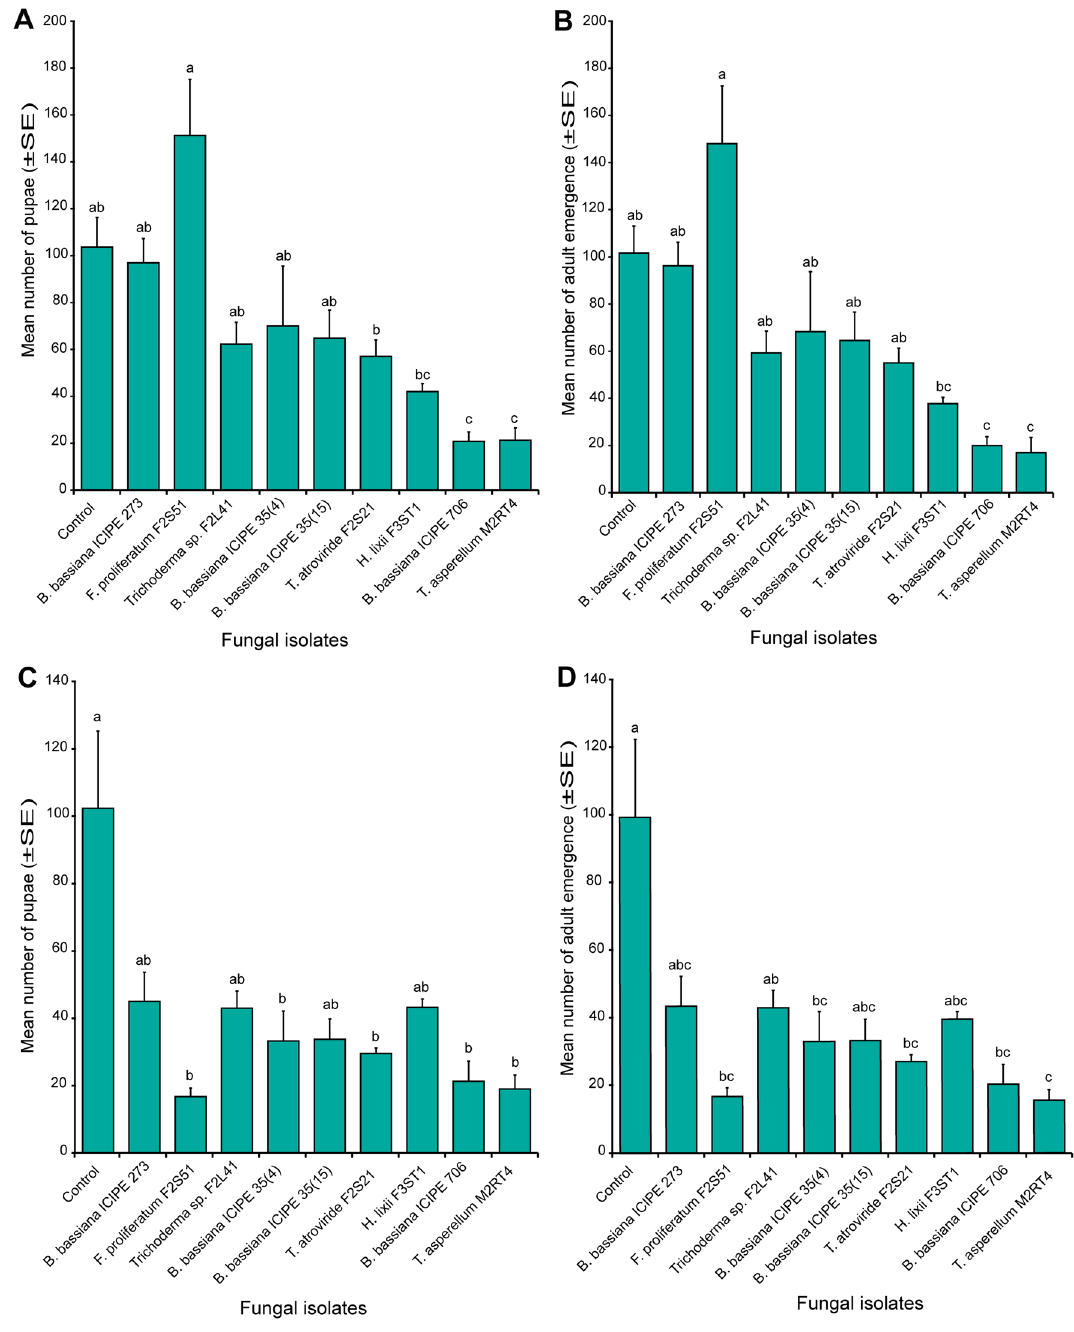
Figure 4. Effect of endophytically-colonized host plants by fungal isolates on Tuta absoluta pupation and adult emergence. ( A ) Bar chart showing mean number (± SE) of Tuta absoluta pupae produced on endophytically- colonized tomato plants. ( B ) Bar chart showing mean number of Tuta absoluta adults emerging from endophytically-colonized tomato plants. ( C ) Bar chart showing mean number (± SE) of Tuta absoluta pupae produced on endophytically-colonized nightshade plants. ( D ) Bar chart showing mean number of Tuta absoluta adults emerging from endophytically-colonized nightshade plants. Means followed by a different lowercase letters are significantly different ( P < 0.05; n = 4; Tukey’s HSD species in both host seedlings 46 . In this study, the highest recovery of B. bassiana was from the roots of the plants which indicates that through seed inoculation this strain has gained access to the cells of the plant. This confirms the observation that many endophytic fungi originate from the rhizosphere microbiota, an environment which attracts microorganisms better due to the presence of root exudates and rhizodeposits 47 . On the other hand, Behie et al. 15 reported that endophytic fungi may display preferential tissue colonization within their host plants owing to many factors, including plant tissue type, plant genotype, microbial taxon and strain type 40 . Even though M.